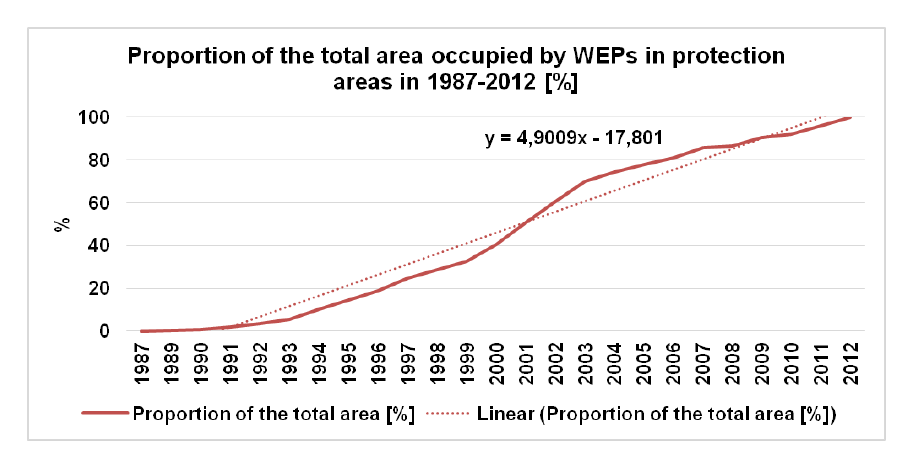
Figure 3. Proportion of the total area occupied by WEPs in protection areas between 1987 and